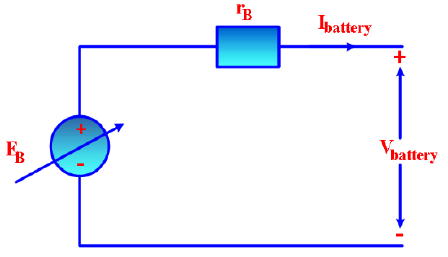
Figure 4. Electric equivalent circuit ‐ based battery model.